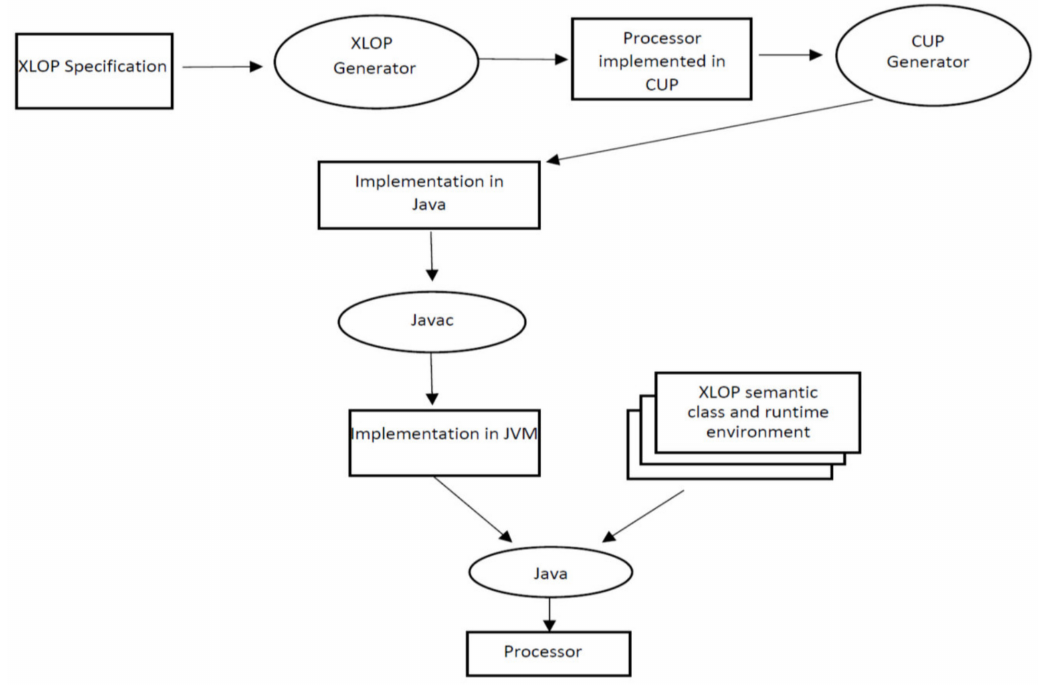
Figure 2. Life cycle for the production of XML